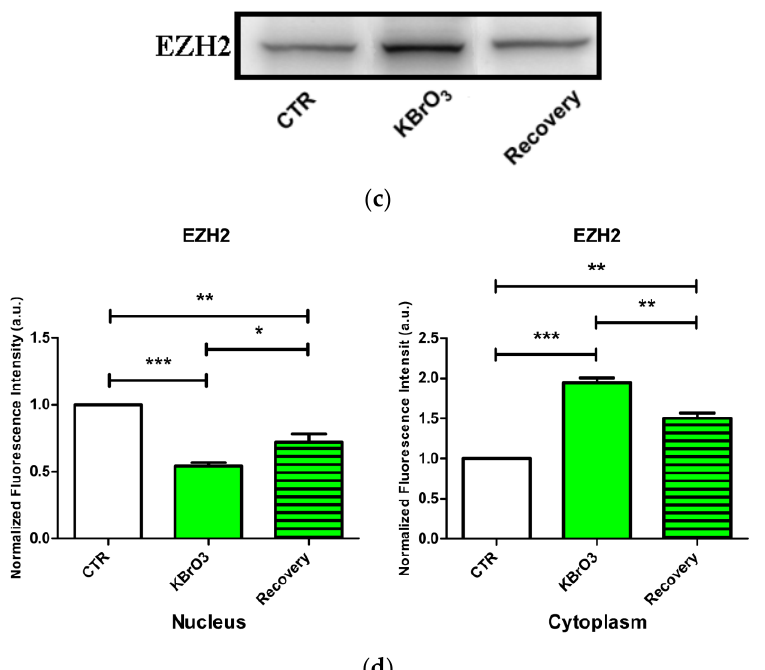
Figure 4. ( a ) qPCR gene expression analysis. No statistical significance differences are highlighted. ( b ) Dual STED displaying DNA (cyan) and EZH2 (magenta) in HeLa cells during experimental conditions. Note the diverse EZH2 signal in each condition. Bars: 10 μm. ( c ) Western blot analysis of potassium bromate-treated cells with antibody targeting EZH2 (see Figure S1). ( d ) Histograms representing the normalized fluorescence intensity of EZH2 signal in the nucleus and in the cytoplasm. Note the nuclear labelling reduction and the simultaneous cytoplasm signal increment during KBrO 3 stress. Asterisks identify statistically significant differences (*: p Value < 0.05; **: p Value < 0.01; ***: p Value < 0.001).